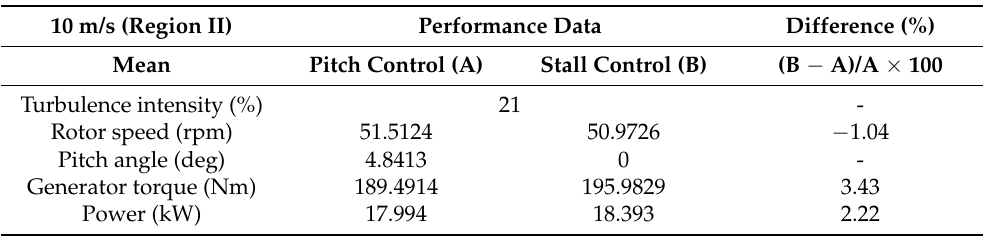
Table 2. Quantitative comparison of controller performance at an average wind speed of 10 m/s (mostly Region II and II-1/2).